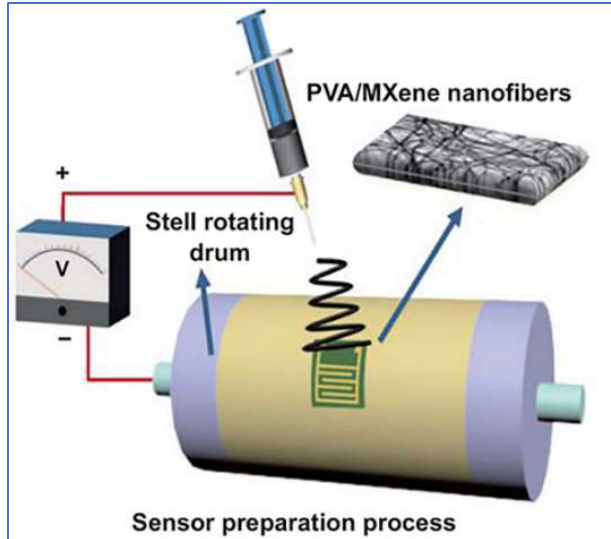
Figure 8. Schematic of preparation process of the PVA/MXene nanofibers via electrospinning